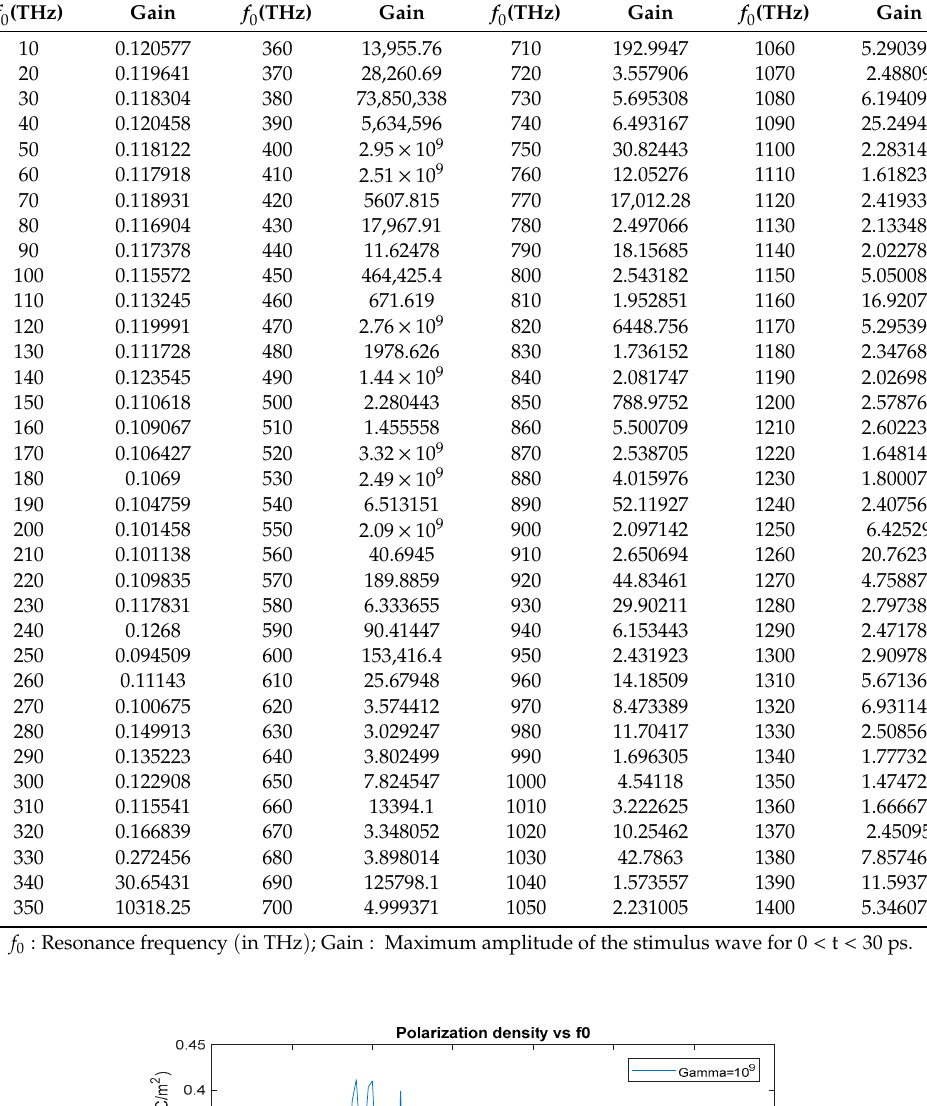
Table 2. Maximum stimulus wave amplitude (gain factor) inside the cavity at x = 5.73 µ m for